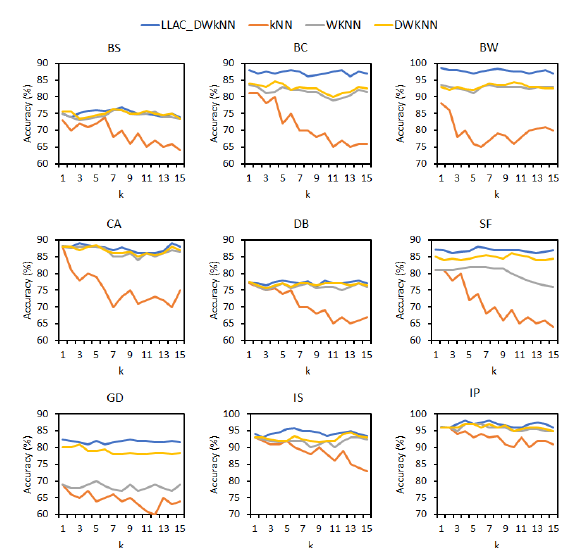
Figure 3 The average accuracy v/s the neighborhood size k for different